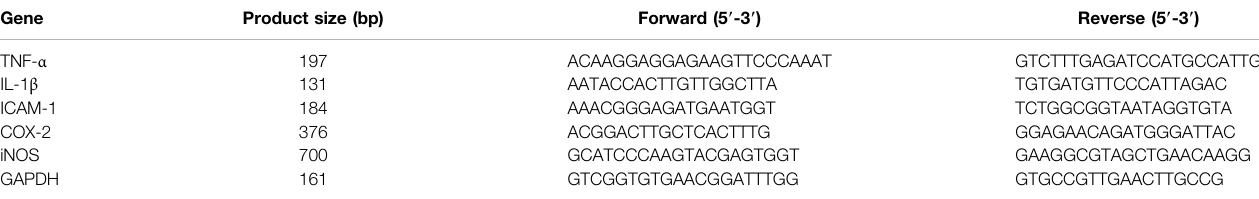
TABLE 1 | Primer sequences used for RT-PCR